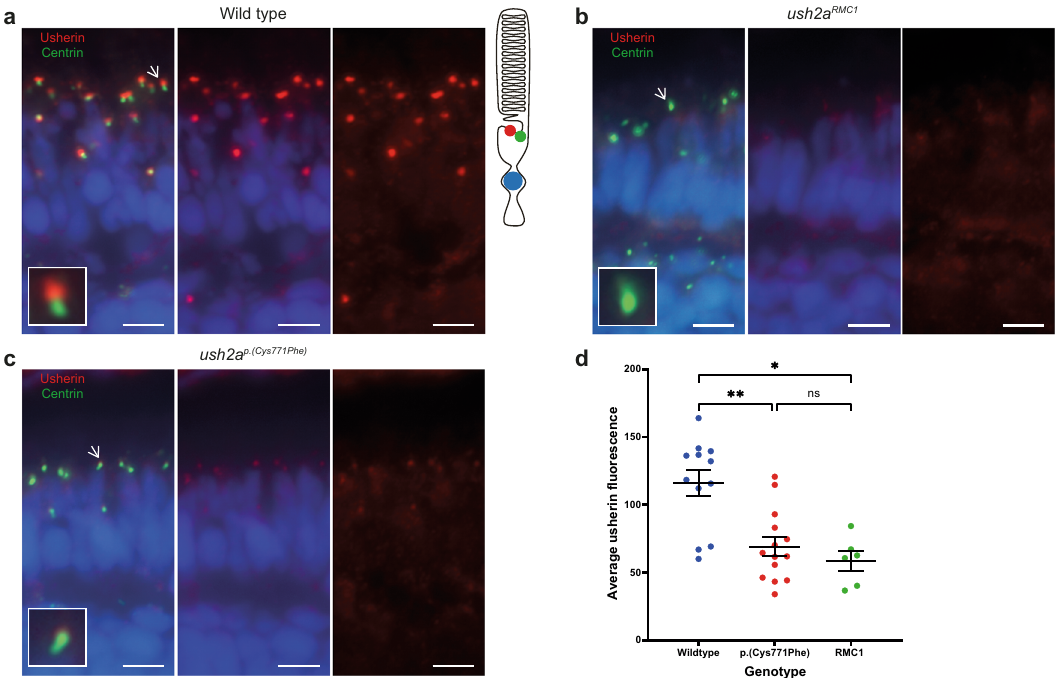
Fig. 3 Reduced expression level of usherin p.(Cys771Phe) at the photoreceptor periciliary membrane. a In wildtype zebra fi sh larval eyes ( n = 12 eyes), usherin (red signal) localizes at the photoreceptor periciliary membrane adjacent to the basal body and connecting cilium marker centrin (green signal) as shown by the schematic representation of a photoreceptor on the right. A magni fi cation of one photoreceptor (indicated by an arrow) is depicted in the inlay. b In ush2a rmc1 knock-out larvae usherin is not detectable ( n = 6 eyes). c Localization of usherin at the photoreceptor periciliary membrane was strongly reduced in eyes of ush2a p.(Cys771Phe) larvae ( n = 14 eyes) as compared to wildtype. d A Kruskal – Wallis test was performed based on the average of the mean grey value for usherin adjacent to each centrin spot and con fi rmed a signi fi cant decrease of usherin localization adjacent to centrin for the usherin p.(Cys771Phe) and the usherin RMC1 models. The average grey value per retinal section was plotted in a scatter plot (mean ± SEM). Nuclei are stained with DAPI (blue signal). Scale bar: 5 µM. ** p : 0.0094, * p : 0.0107, ns not signi fi cant.